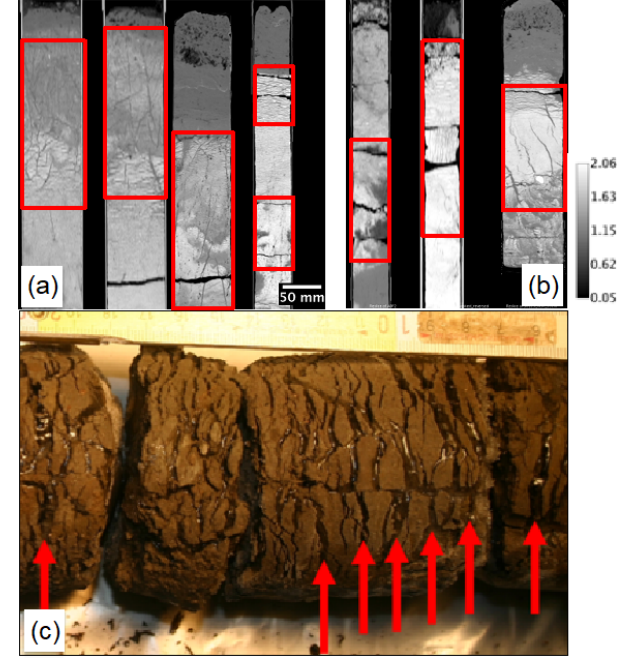
Figure 12. Vertical cross sections of X-ray CT scans of the top 40cm of cores from (a) low-centered polygons and (b) high- centered polygons. The CT scans show the density distribution from low (dark) to high (white) with a calibration bar shown in grams per cubic centimeter (gcm − 3 ). Red boxes indicate patterns of vertical and horizontal density contrasts. Frozen core sampled from satu- rated tundra (c) is analogous to a low-centered polygon. Red arrows indicate prominent ice lenses. Ice lenses are formed at freeze-up when the soil is sufficiently saturated. Notice that most ice lenses are horizontal relative to ground surface. Photo credit: Vladimir Ro-